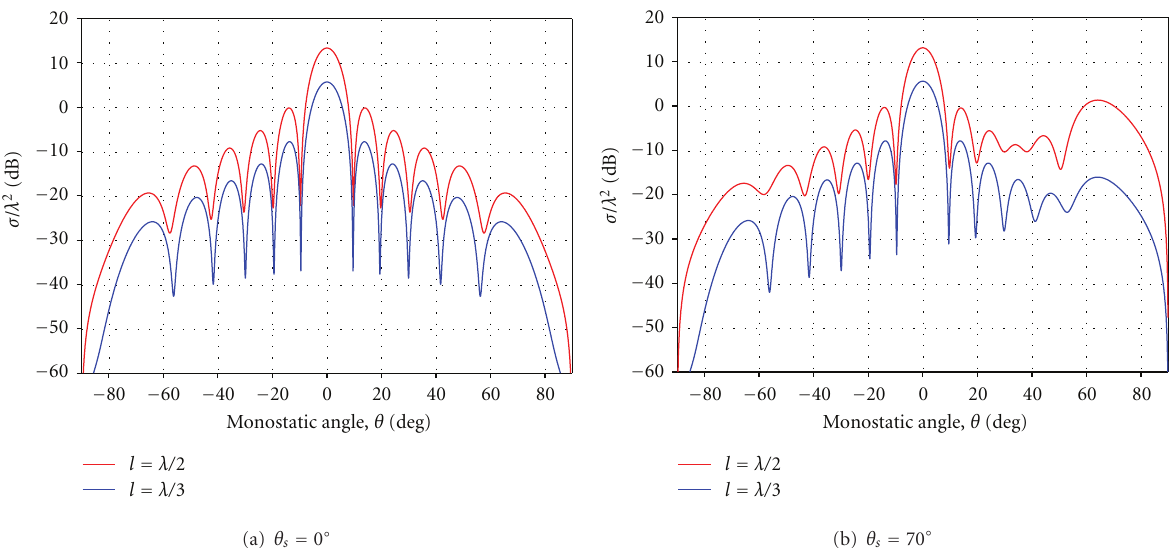
Figure 21: E ff ect of dipole length on RCS of 30-element series-fed linear parallel-in-echelon dipole array including mutual coupling e ff ect.